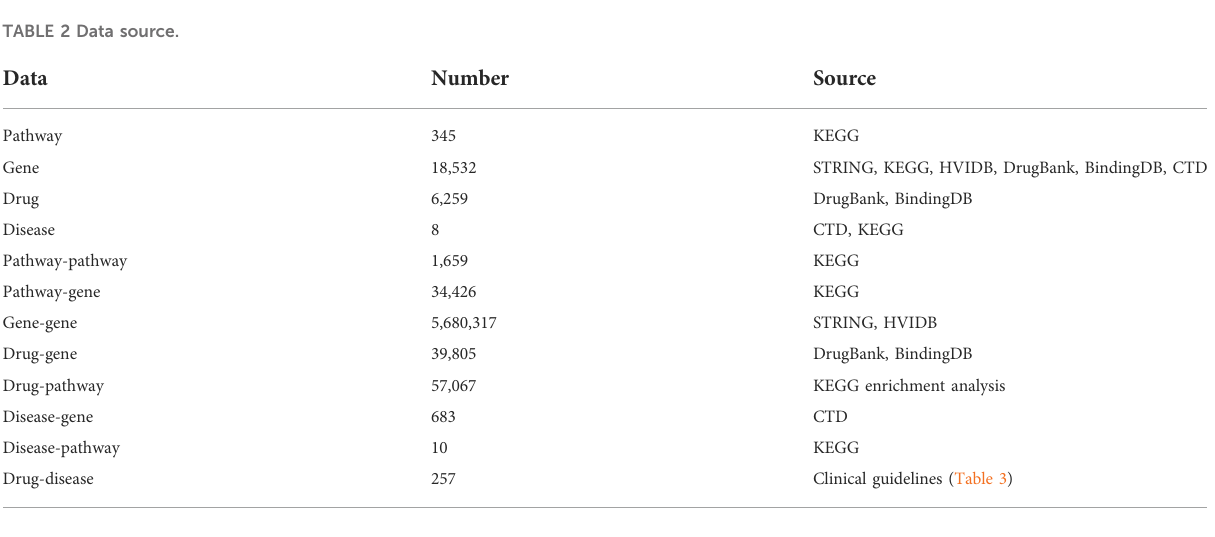
TABLE 2 Data source.